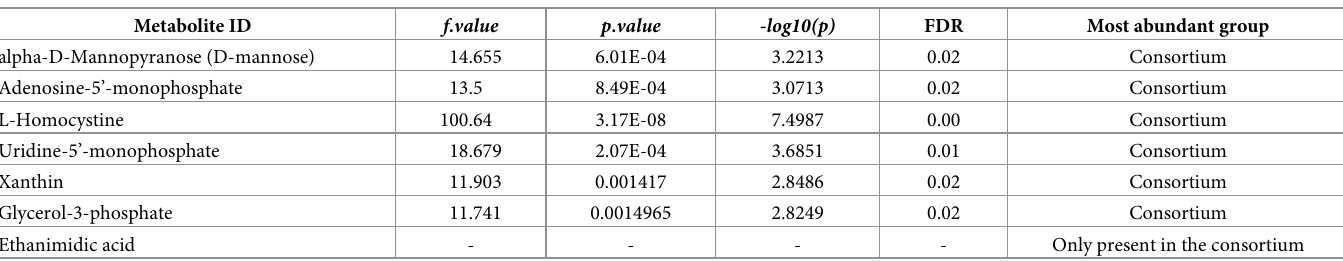
Table 1. Biomarkers of the consortium.